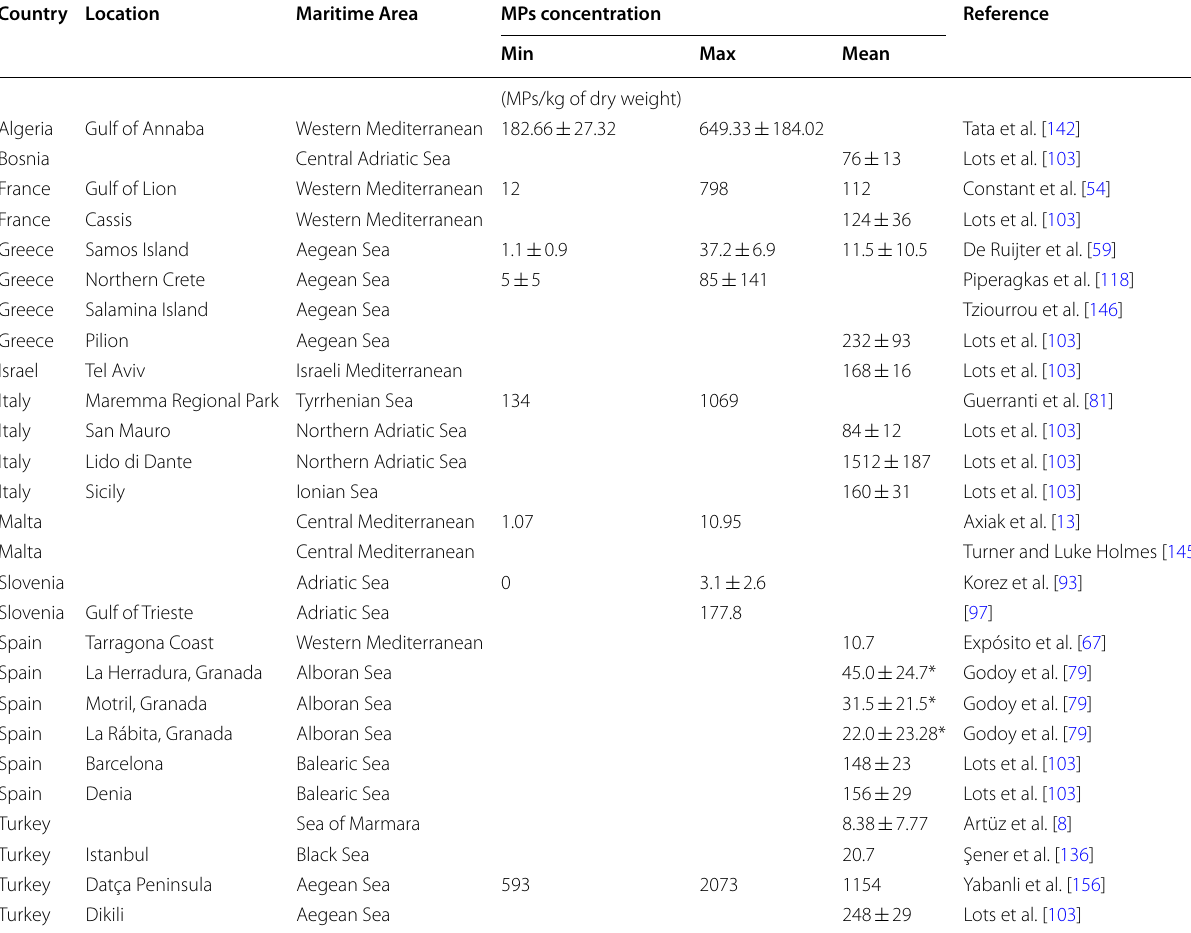
Table 7 A summary of the number of MP found on beaches around the Mediterranean basin (items per kg of dry weight) Country